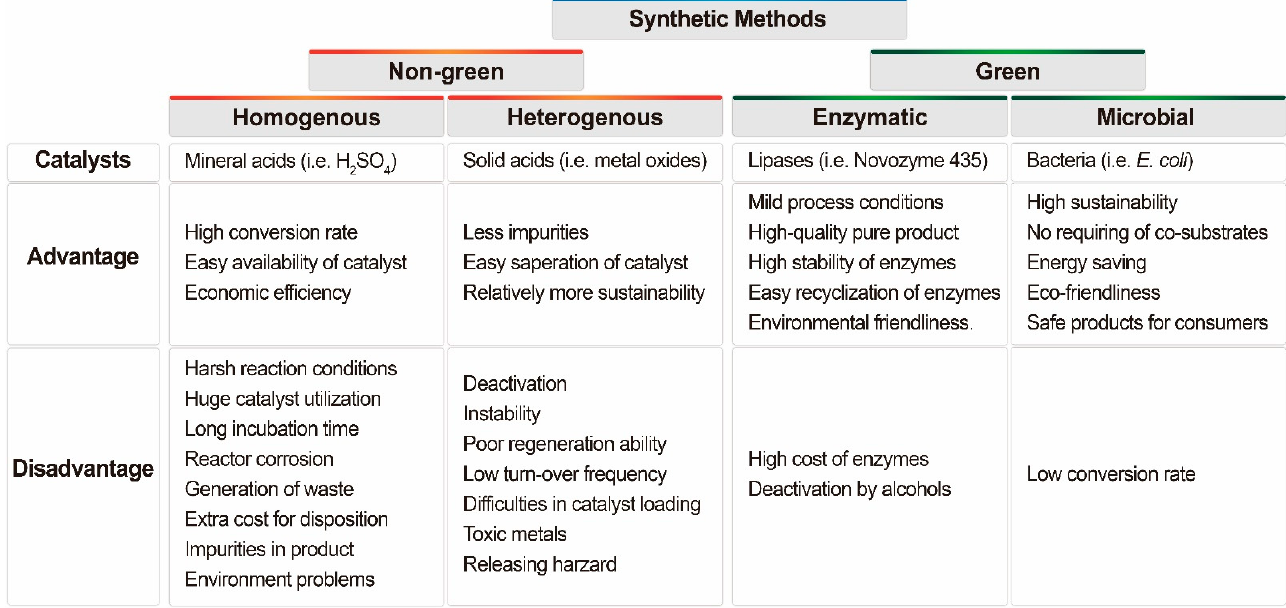
Figure 3. Advantages and disadvantages of different catalysts used in green and non-green synthesis methods of acetins.